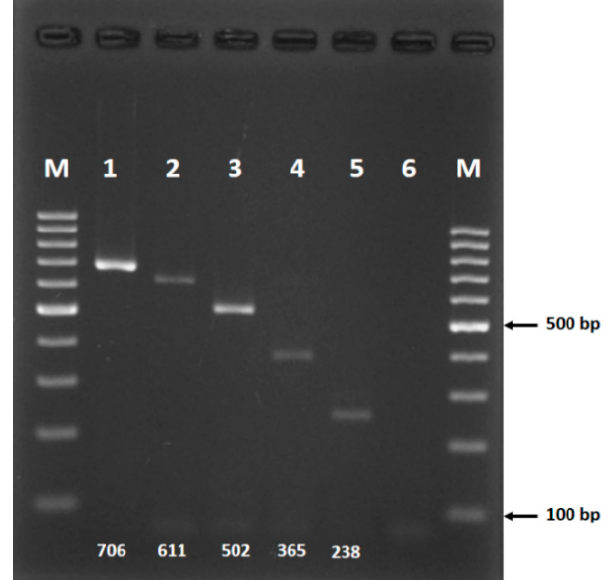
Figure 3. PCR products from the multiplex-PCR assay run on 2% agarose gel. Lanes: 1, An. barbirostris s.s.; 2, An. saeungae ; 3, An. wejchoochotei ; 4, An. barbirostris A3; 5, An. dissidens ; 6, negative control. The 100-bp molecular weight ladders are loaded in M lanes.